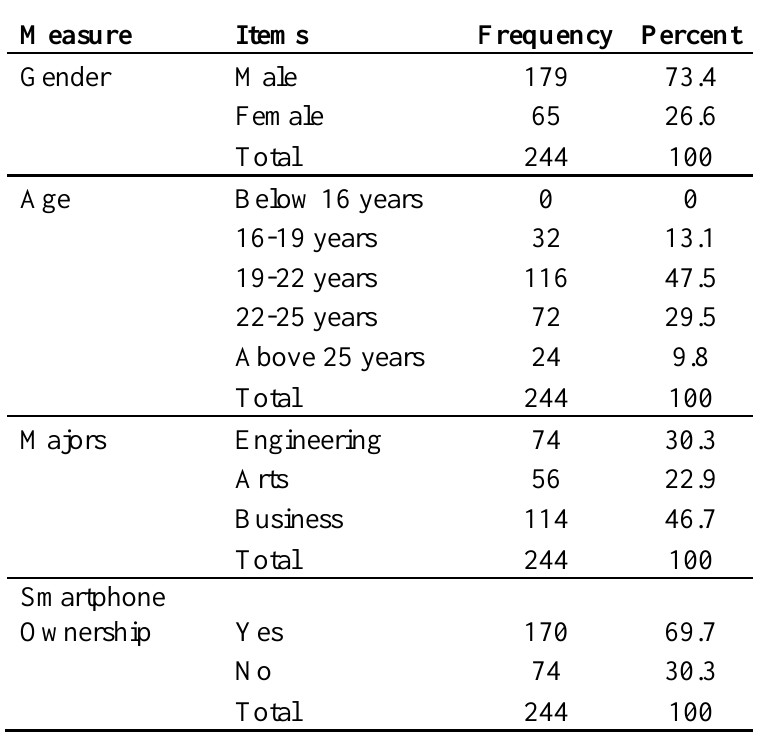
Demographic Profile of